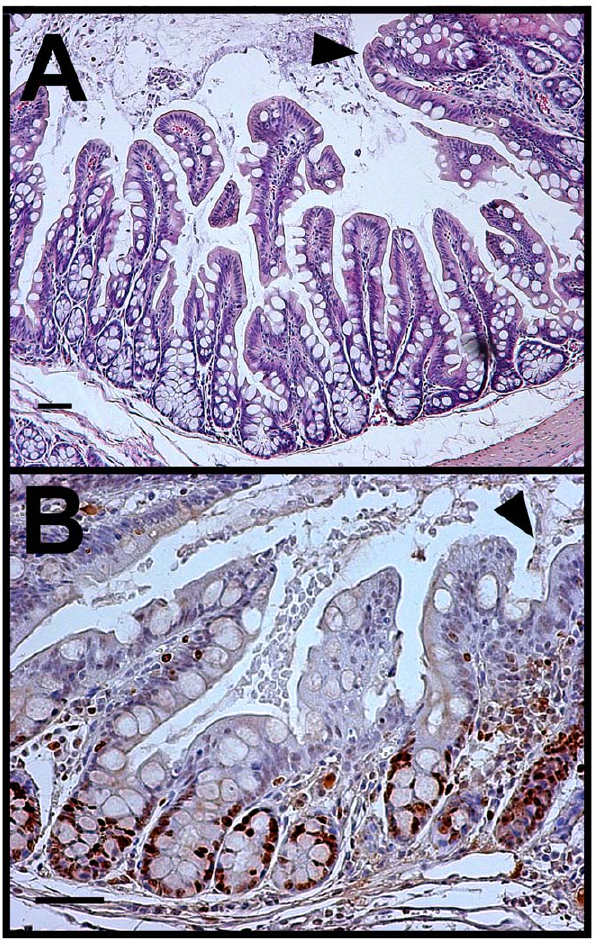
Figure 7. Kras G12D mutation was associated with patches of villus-like structures in the ascending colon. A. H&E staining shows villus-like architecture in an area of the ascending colon. Normal colonic crypt structure resumes on upper right side of each panel (arrowhead). B. Immunolabeling for Ki67 (brown) indicates that the proliferative zones associated with villus-like structures are similar in cell number to normal colonic crypts. Size bars, 50 m m.